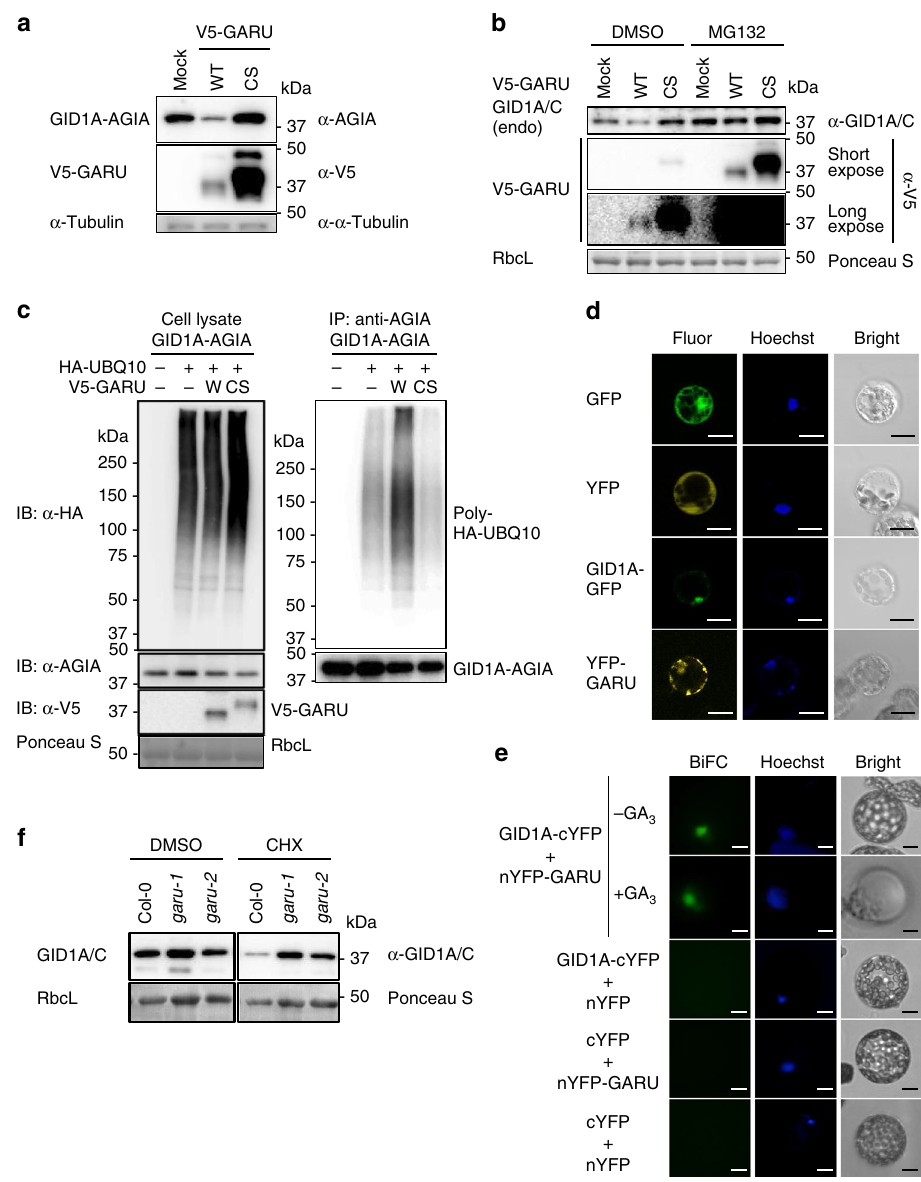
Fig. 2 GARU-dependent ubiquitination induces degradation of GID1s. a Destabilization assay of exogenous GID1A-AGIA. GID1A-AGIA was co-expressed with V5-GARU (WT) or V5-GARU C190/193S mutant (CS) in protoplasts. b Destabilization assay of endogenous GID1. V5-GARU (WT) or V5-GARU C190/193S mutant (CS) was transfected into protoplasts. After incubation with 20 µ M MG132 or 0.1% DMSO for 6 h, expressed proteins were analyzed by immunoblotting. c In cell ubiquitination assay of GID1A. GID1A-AGIA was co-expressed with V5-GARU or V5-GARU C190/193S (CS), and 3 × (HA-UBQ10) in protoplasts. After incubation with 20 µ M MG132 for 6 h, GID1A-AGIA was immunoprecipitated with anti-AGIA antibody sepharose beads from protoplasts lysates. Ubiquitinated proteins (HA-UBQ10) were detected by immunoblotting using anti-HA antibody. d Subcellular localizations of GID1A-GFP and YFP-GARU in Arabidopsis protoplasts. Fluor, GFP, or YFP fl uorescence image; Hoechst, Hoechst 33258 stain fl uorescence image; Bright, bright- fi eld image. Scale bars = 20 μ m. e BiFC analysis of GARU – GID1A interaction in Arabidopsis protoplast. The C-terminal half of YFP fused GID1A (GID1A-cYFP) and the N-terminal half of YFP fused GARU (nYFP-GARU) were co-expressed in protoplasts, and incubated with or without of 10 μ M GA 3 . nYFP and cYFP were co-expressed with GID1A-cYFP or nYFP-GARU as a negative controls. BiFC, YFP fl uorescence image; Hoechst, Hoechst 33258 stain fl uorescence image; Bright, bright- fi eld image. Scale bars = 10 μ m. f Immunoblot analysis of GID1 proteins in Col-0, garu-1 , and garu-2 that were treated with 0.1% DMSO or 300 µ M CHX for 20